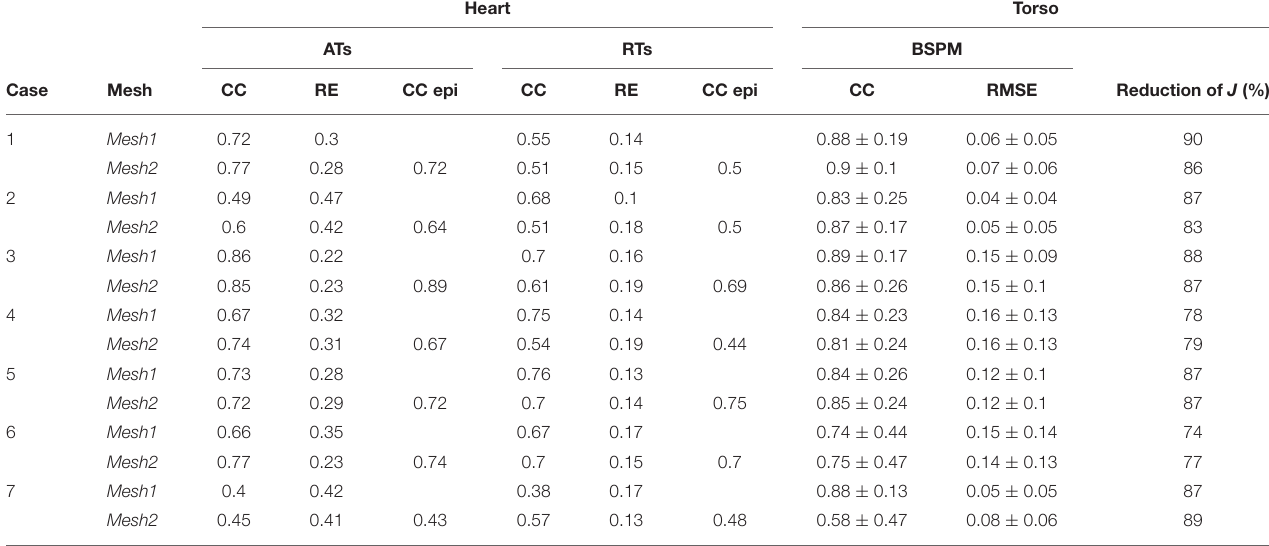
TABLE 3 | Results for the 7